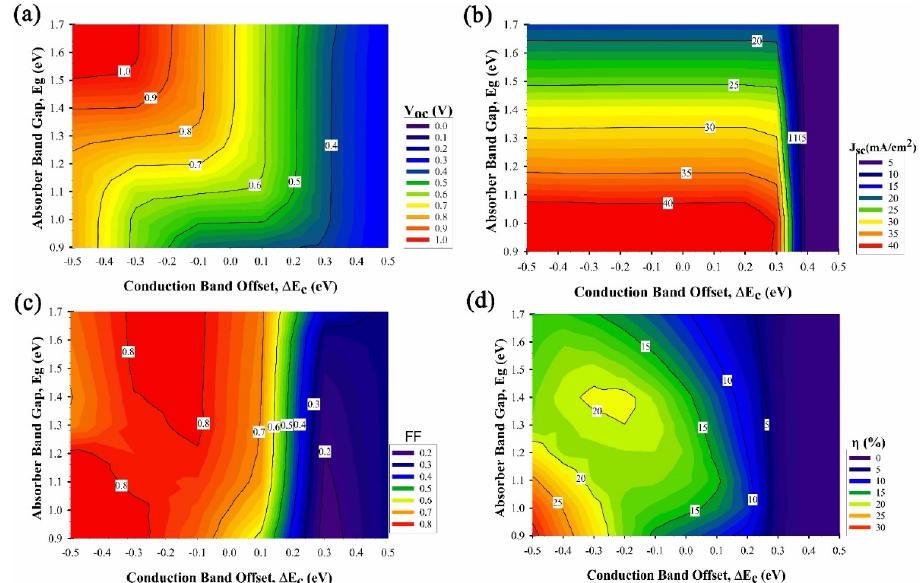
Figure 4. Photovoltaic performance parameters ( a ) V oc , ( b ) J sc , ( c ) FF and ( d ) efficiency for an ideal p-absorber layer with a CdS buffer layer of Set A (µ: 1 cm 2 /V·s and N D : 10 14 cm −3 ).